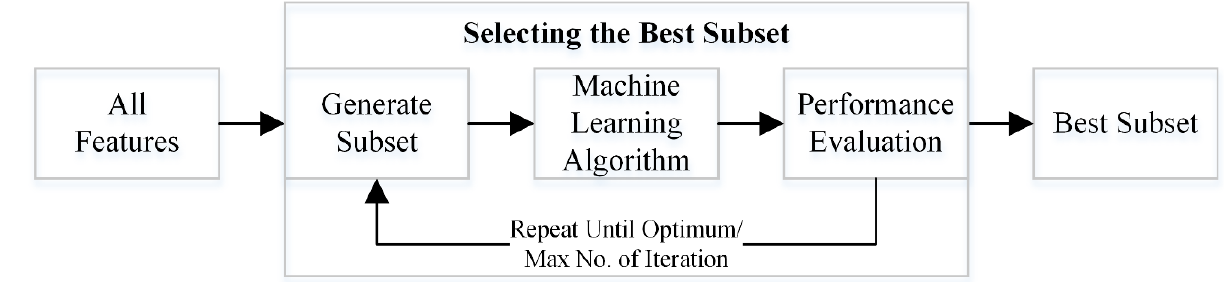
Figure 3. Schematic of the working of the wrapper-based method.